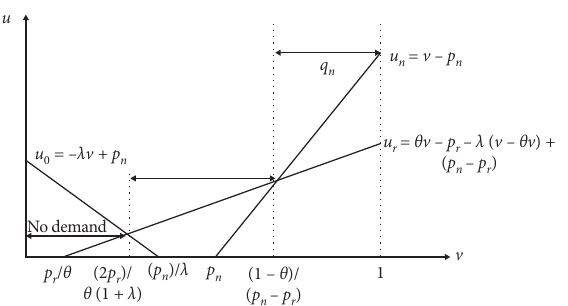
Figure 3: The loss-averse consumer